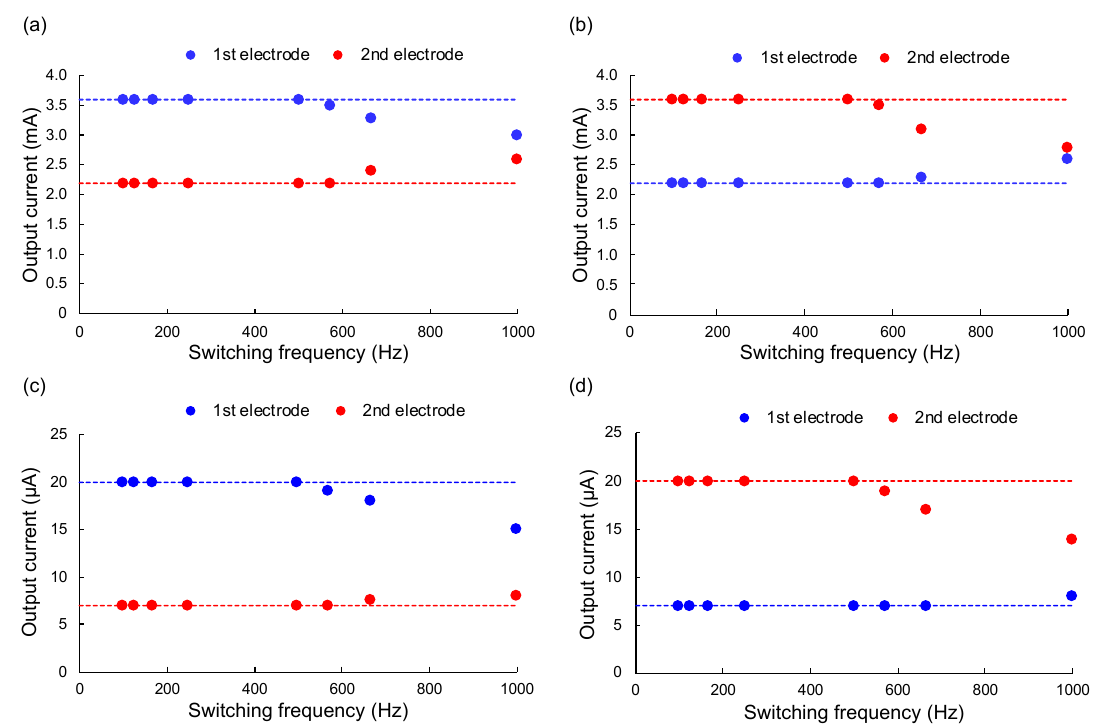
Figure 8. Experimental results for the switching of two electrodes for different frequencies: ( a ) When the output currents in the 1st and 2nd electrodes were set to 3.6 mA and 2.2 mA, respectively; ( b ) When Table 1st and 2nd electrodes were set to 2.2 mA and 3.6 mA, respectively; ( c ) When the output currents in the 1st and 2nd electrodes were set to 20 µ A and 7 µ A, respectively; ( d ) When the output currents in the 1st and 2nd electrodes were set to 7 µ A and 20 µ A, respectively. Dashed lines indicate the target output current in each electrode.